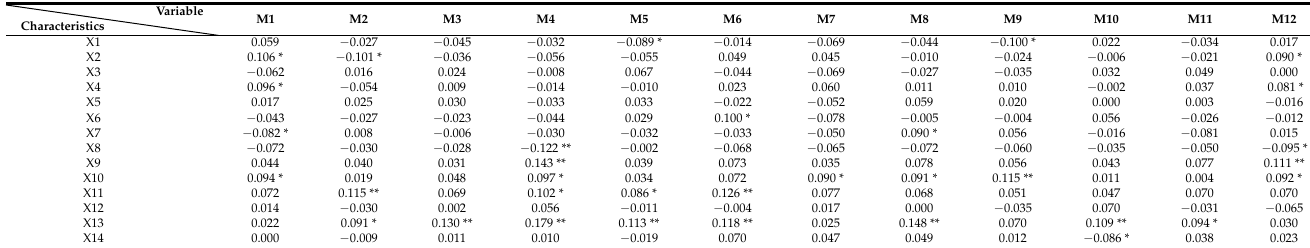
Table 4. Correlation table between resident perceptions and individual characteristics.